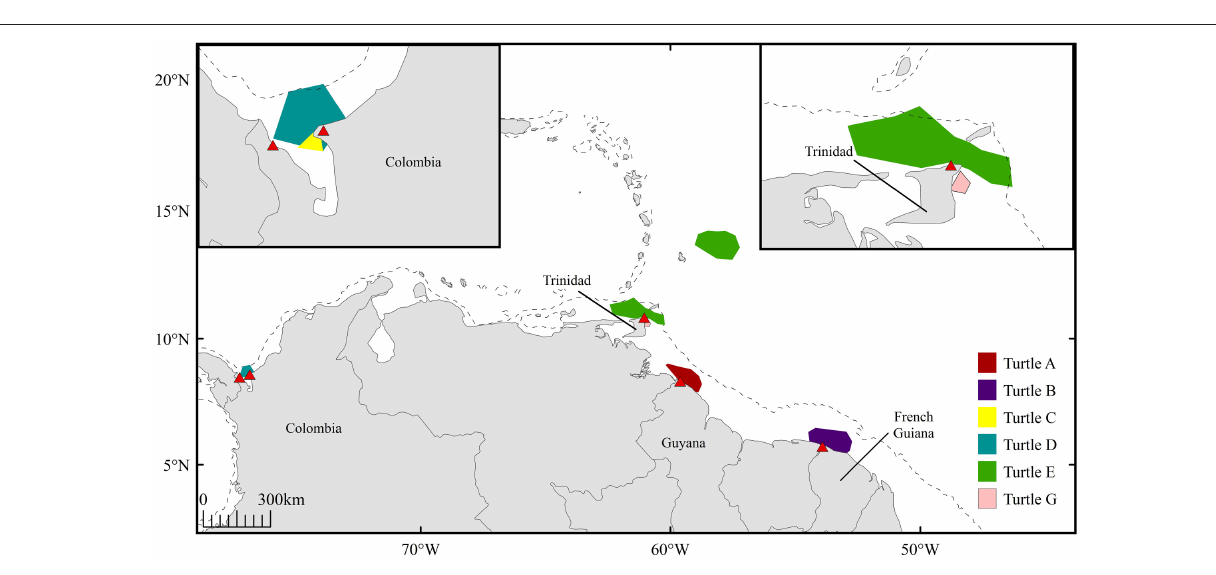
FIGURE 4 | High-use areas defined by 50% volume contours for 6 female leatherbacks (turtles A-E, G) during inferred mating period 45 days prior to confirmed nesting events; red triangles indicate corresponding nesting sites in Guyana ( n = 1), French Guiana ( n = 1), Trinidad ( n = 1), and Colombia ( n = 2). Dashed line represents 200m